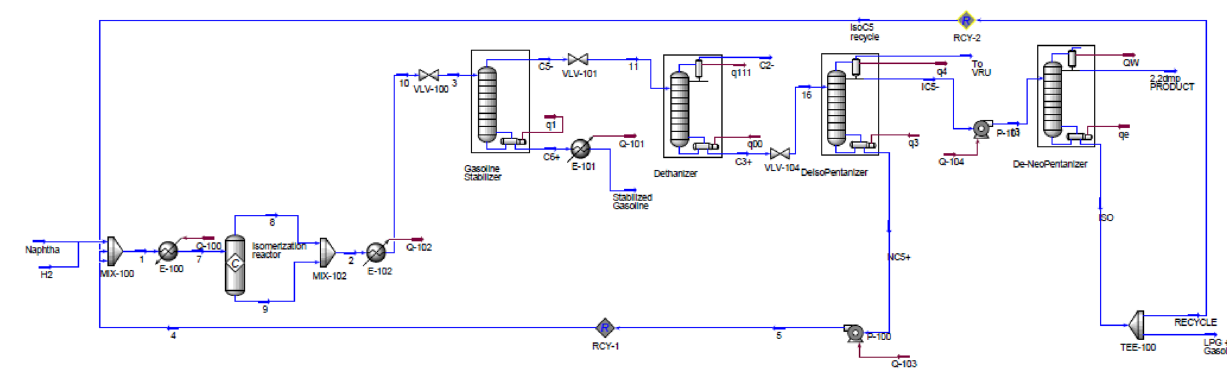
Fig. 44 Process flow sheet of neo-pentane